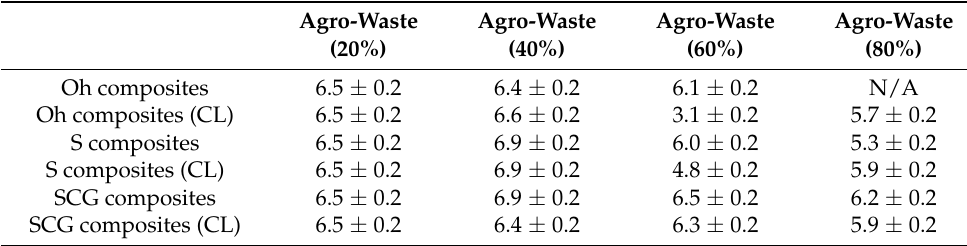
Table 6. Water content at 23 ◦ C and laboratory conditions at ambient humidity calculated through the weight loss at 150 ◦